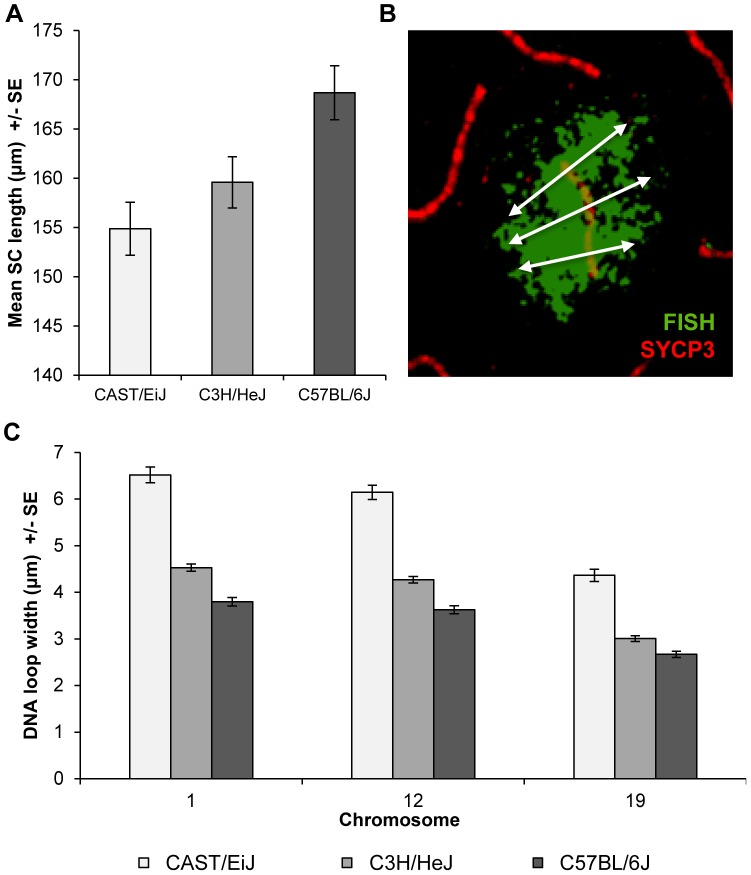
Inter-strain variation in SC length and DNA loop size.(A) Mean autosomal SC lengths varied in direct relationship to MLH1 values; i.e., the strain with the lowest mean MLH1 values (CAST) had the shortest SCs, while the strain with the highest MLH1 values (B6) had the longest SCs. Data are based on analyses of mid-pachytene spermatocytes from 2 CAST (n = 8 cells), 3 C3H (n = 11 cells) and 2 B6 (n = 21 cells) males. (B) DNA loop sizes for individual chromosomes were calculated as the average of the width of the FISH signal at three points along the SC: at the centromere, the midpoint, and the telomere; image shows example for chromosome 12. (C) Chromosomes 1, 12, and 19 were examined and for each, we observed an inverse relationship between strain-specific mean MLH1 values and mean DNA loop sizes.